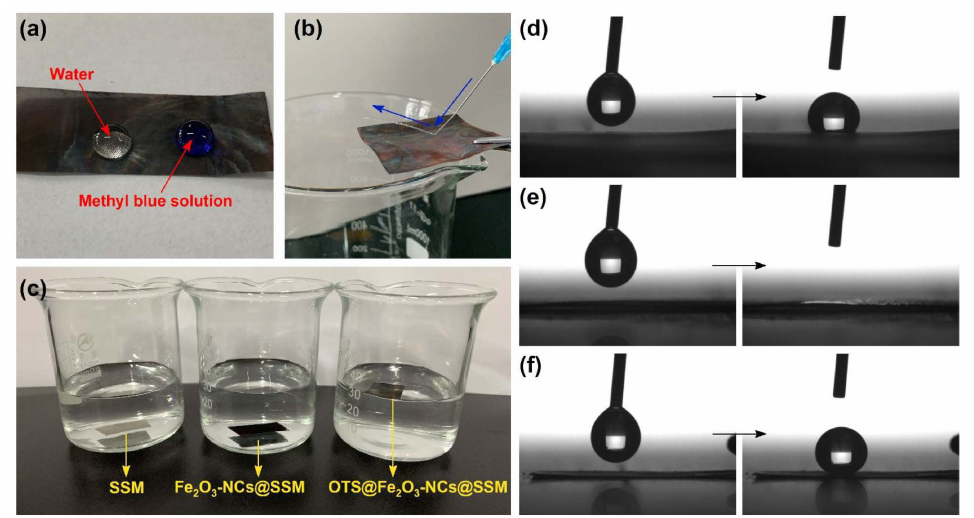
Figure 6. ( a ) Water and methyl blue droplets on the top of OTS@Fe 2 O 3 -NCs@SSM. ( b ) The water column reflects image on the surface of OTS@Fe 2 O 3 -NCs @SSM. ( c ) The floating test on water of the samples. ( d – f ) The water static contact-angle measurement of SSM, Fe 2 O 3 -NCs@SSM, and OTS@Fe 2 O 3 -NCs